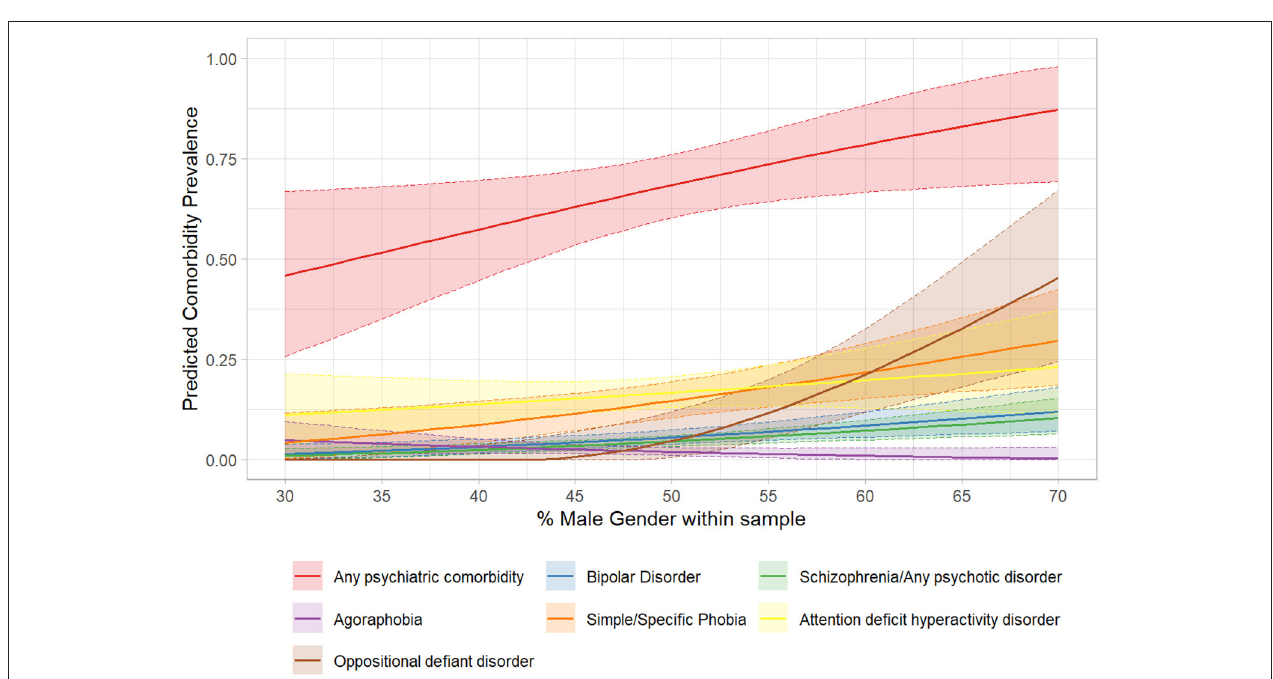
FIGURE 6 | Significant meta-regressions by mean Y-BOCS/CY-BOCS total score in the samples. The prevalence rates of Panic Disorder, OCRDs, Tic Disorder, Anorexia Nervosa & OCPD are lower in samples with higher illness severity.